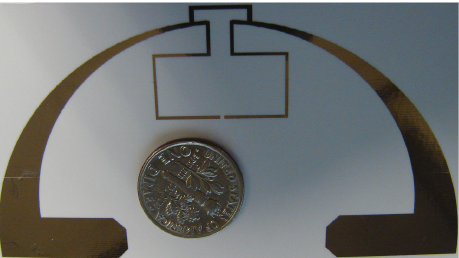
Figure 3: Typical RFID tag